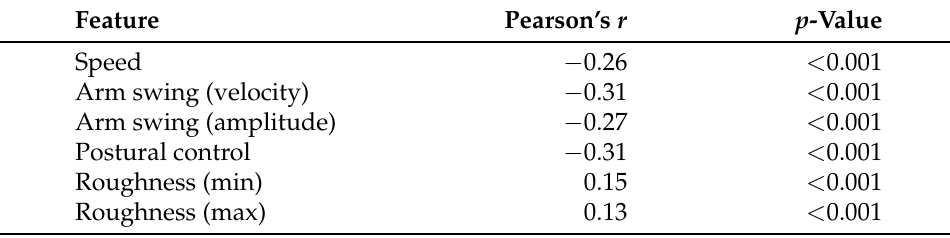
Table 2. Association between feature values and total UPDRS part-III scores. The postural